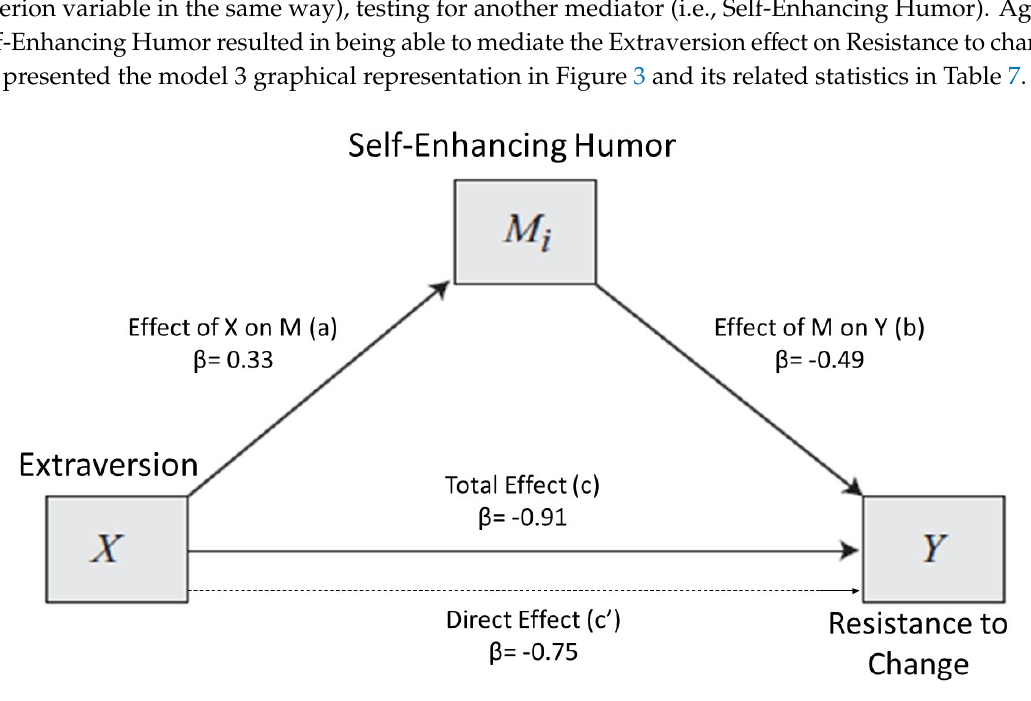
Figure 3. Model 3. Relationship between Extraversion and Resistance to Change, with Self-Enhancing Humor as a mediator. k² mediator effect size = 0.09. Table 7. Model 3. Mediation analysis statistics. In the upper part of the table, the indexes related to each regression analysis needed for testing the mediational model are summarized. In the lower part, the coefficients for each path of the mediation model are provided.